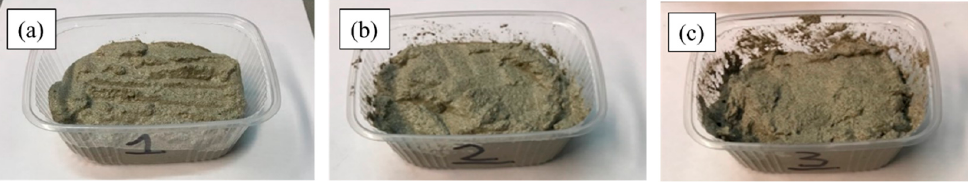
Figure 2. Samples of the Thermacoat™ powder mixed with water ( a ), with 2.5 wt.% excess addition of cenospheres ( b ) and 1 wt.% polypropylene fibers ( c ).